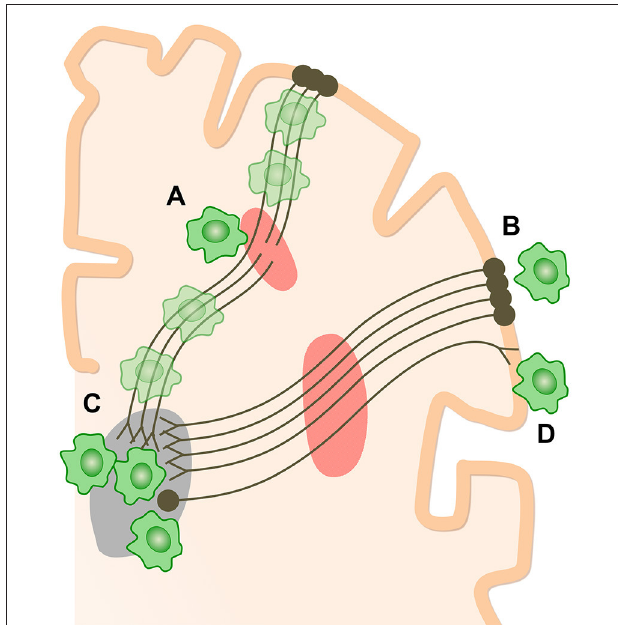
FIGURE 3 | How chronic microglial activation and axonal injury may be linked after TBI. Microglial activation (green cells) and traumatic axonal injury in thalamo-cortical white matter tracts (red areas) have been demonstrated after TBI. Sites of chronic microglial activation can co-localize with axonal abnormality (A) as well as along the entire axonal tract affected by injury. Remote from sites of primary axonal injury, microglia may be observed both in retrograde projection areas, toward the cell bodies of damaged neurons (B) , and in anterograde areas (C,D) . The thalamus is a highly-connected structure. Thalamic microglial activation may be observed after TBI because of the high density of connections to damaged axons. The number of cortico-thalamic projections far exceeds thalamo-cortical projections. If microglial activation preferentially favors anterograde involvement, then relatively increased activation would be expected in the thalamus (C) compared to corresponding cortical areas (B)